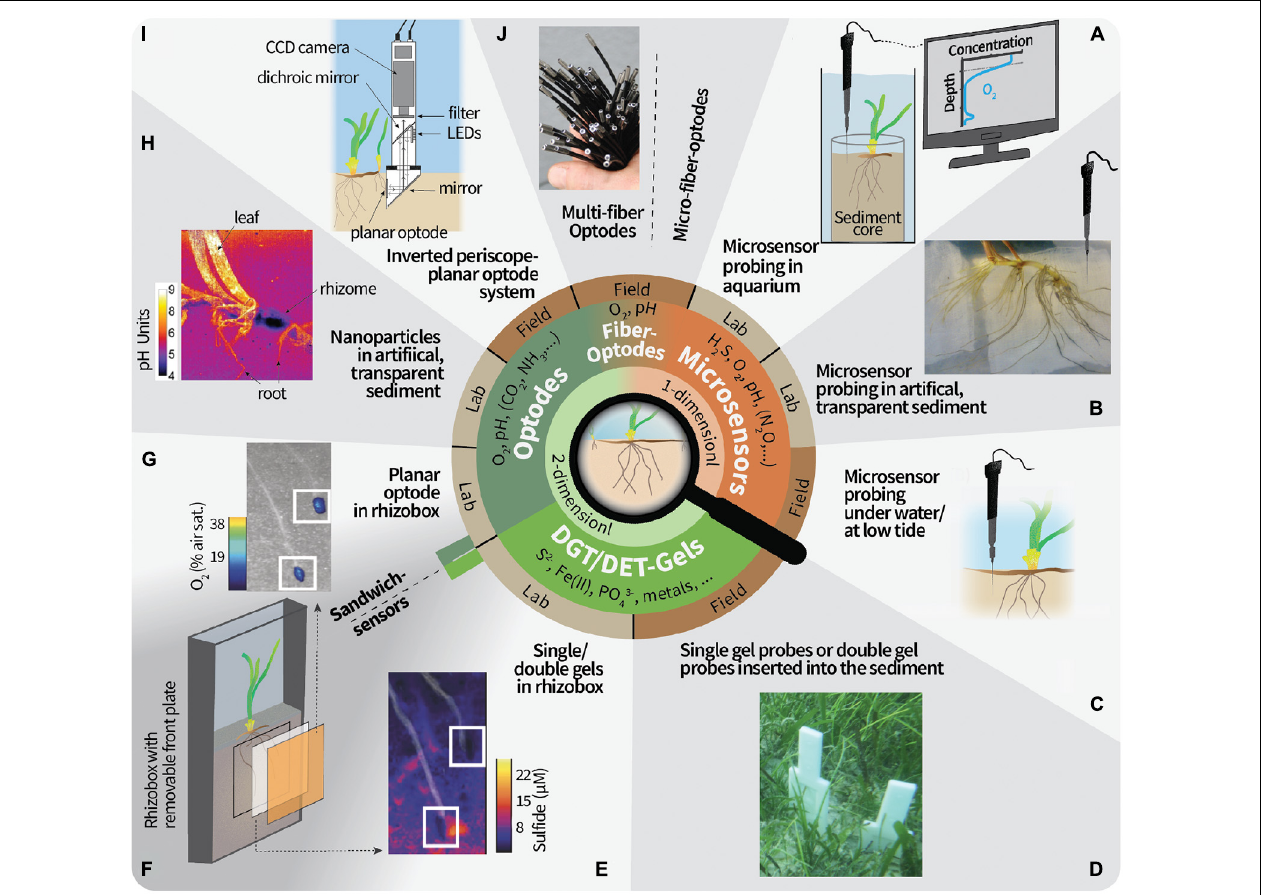
FIGURE 1 | Overview of 1- and 2-D techniques to study the geochemistry in the seagrass rhizosphere microenvironment. (A) Microsensor probing on sediment cores retrieved from the field or seagrass transplanted into sediment in the laboratory. The conceptual microsensor profile of O 2 is taken vertically through the upper layers of the sediment core and allows the calculation of, for example, the sediment diffusive O 2 uptake and the O 2 penetration depth. O 2 excursions below the O 2 penetration depth could be from radial O 2 loss from roots/rhizomes or ventilated fauna burrows. (B) Artificial, transparent sediment in a custom-made split flow chamber (Brodersen et al., 2015b) allows to approach the roots with microsensors from different directions. (C) Microsensor probing under submerged conditions or when the seagrass plants are emerged during low tide have been proven challenging but feasible. (D) Gel probes or gel-sandwich (double) probes have been proven to be a robust field technique. (E) Example result of a sulfide-sensitive gel from a laboratory deployment. The image is modified from Martin et al. (2018) and white squares mark the root tips. (F) Gels can be mounted in between the sediment and planar optodes. (G) Example result of an O 2 -sensitive planar optode. An imaging system needs to be brought in position for the excitation in the dark and read-out of the planar optode. The image is modified from Martin et al. (2018) and white squares mark the root tips. (H) Optode nanoparticles in artificial, transparent sediment overcomes limitations of planar optodes, but cannot be done in natural sediment. Image is taken from Brodersen et al. (2016). (I) In situ instrument for planar optode measurements. Note that this has not yet been deployed in seagrass meadows. Image was modified from Glud et al. (2001). (J) O 2 multi-fiber optode system for the simultaneous recording of 100 datapoints in the field. Note that this has not yet been deployed in seagrass meadows. Image was modified from Fischer and Koop-Jakobsen (2012). Micro-fiber optodes are more robust but with a lower resolution due to the bigger tip size than microsensors made out of